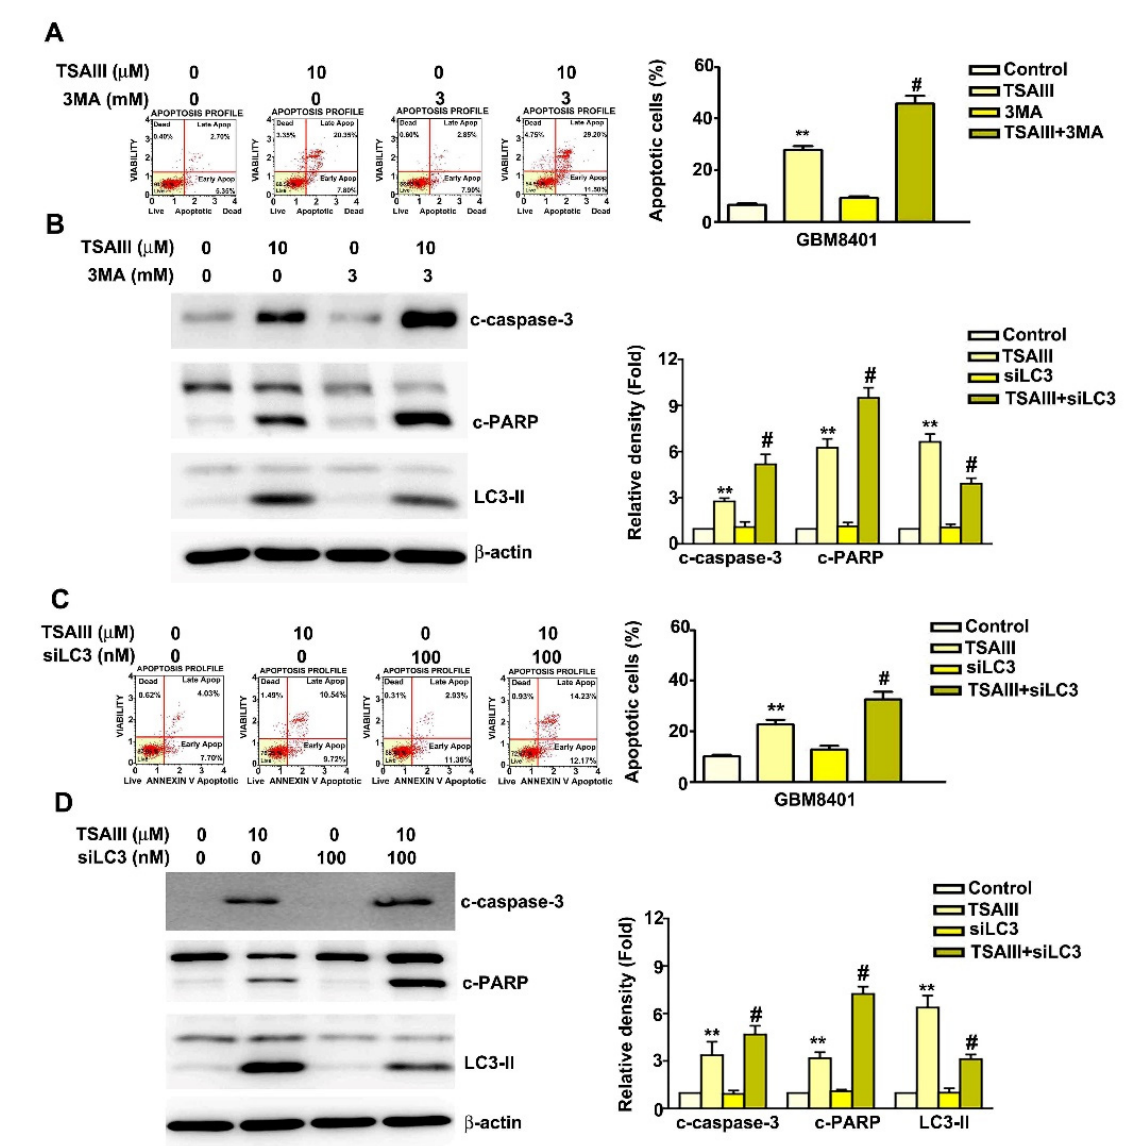
Figure 5. Inhibition of autophagy induced by TSAIII increased apoptosis in human glioma cells. ( A ) Apoptosis assay using Annexin V and flow cytometry of GBM8401 cells treated with TSAIII alone (15 µ M), 3MA alone (3 mM), or combined treatment (TSAIII + 3MA) as indicated for 24 h. ( B ) Western blot assay of c-caspase-3, c-PARP, and LC3-II protein expression. ( C ) GBM8401 cells treated with TSAIII alone (15 µ M), siLC3 (10 nM) alone, or combined treatment (TSAIII + siLC3) for 24 h, then assayed with Annexin V and flow cytometry. ( D ) Western blot assay of c-caspase-3, c-PARP, and LC3-II protein expression. Quantification of band density was performed using ImageJ. Each exper- iment was repeated three times, and data are presented as the mean ± SE. ** p < 0.01 vs. untreated cells (control). # p < 0.05 vs. TSAIII-treated cells.